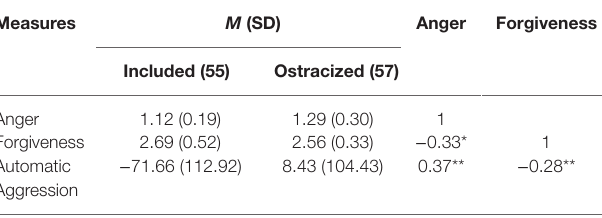
TABLE 1 | Means and standard deviations of the variables in Study